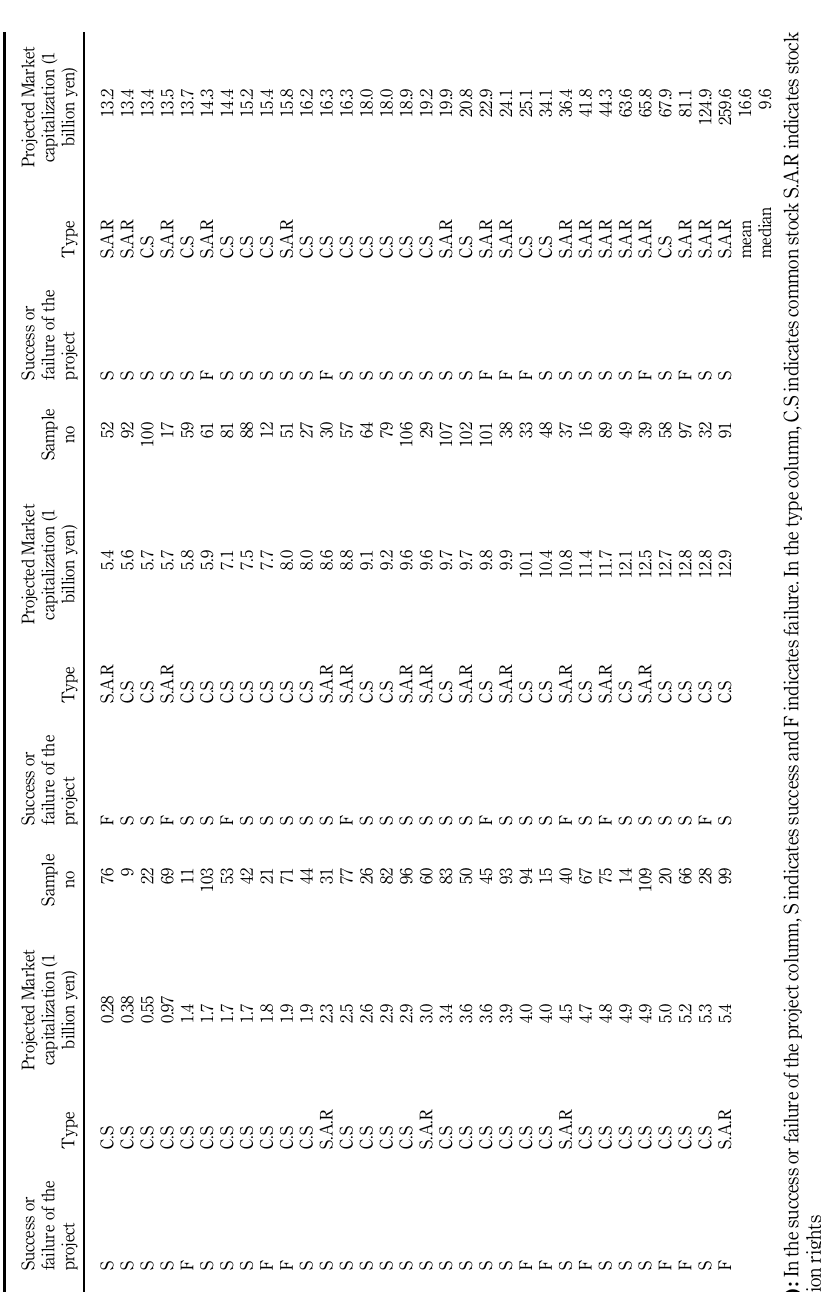
Table 6. Projected market